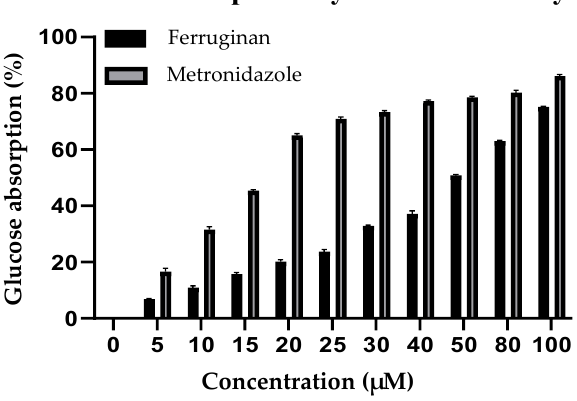
Figure 3. Results of the glucose yeast uptake assay (5 mM glucose) for ferruginan and metronidazole (standard). Experiments were performed in triplicate, and values are reported as mean ± SD.